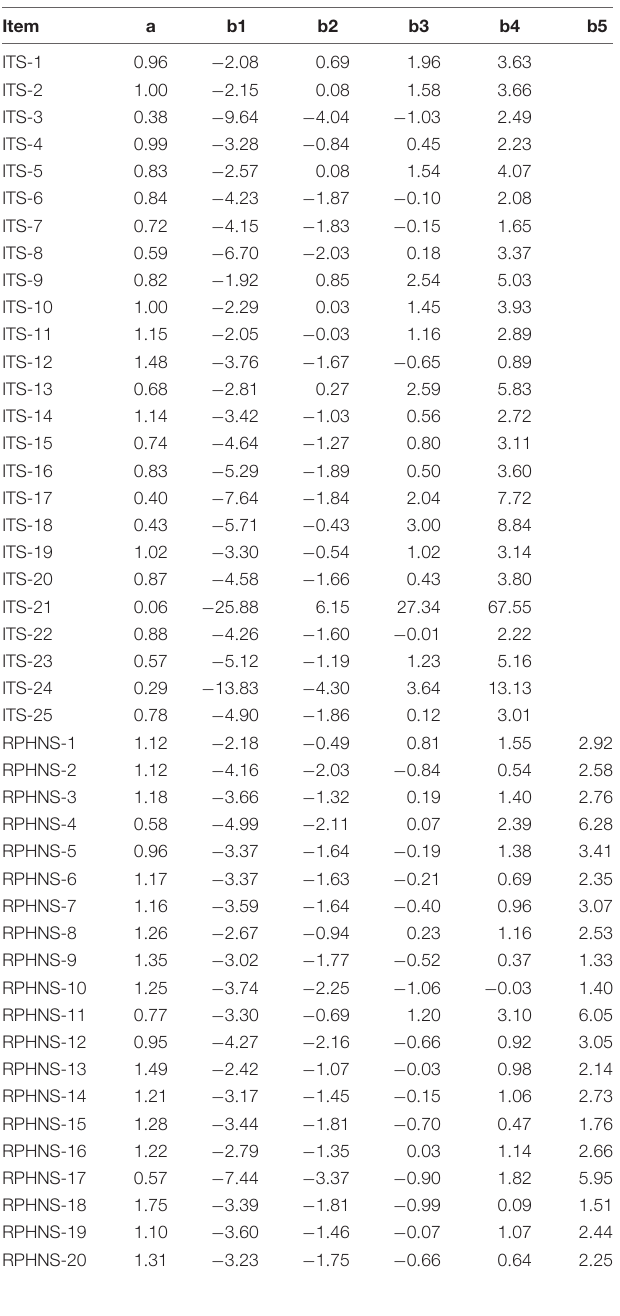
TABLE 4 | Item parameters of the scales (under the